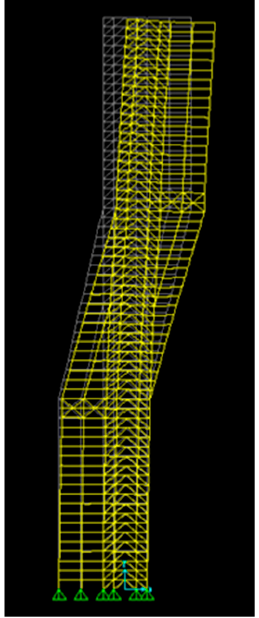
Figure 7. Tilted core-outrigger structure.